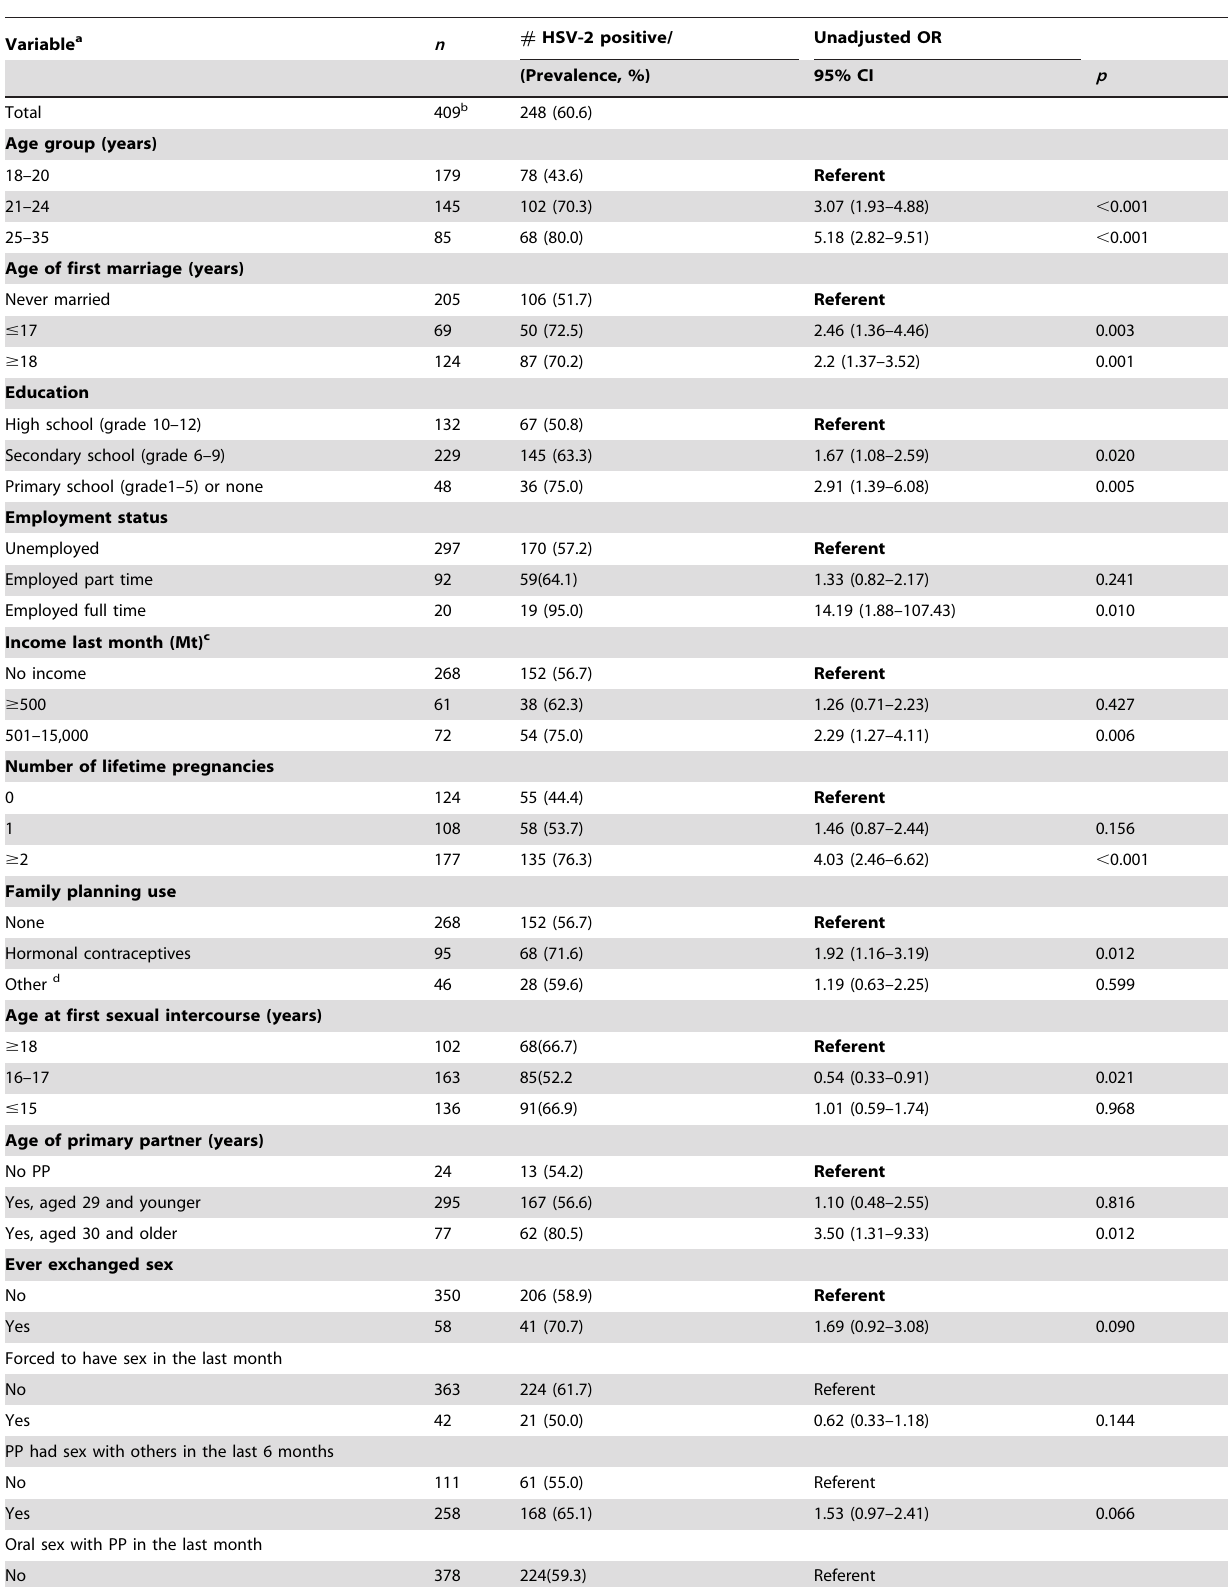
Table 1. Determinants of baseline HSV-2 prevalence among 409 women, Beira,